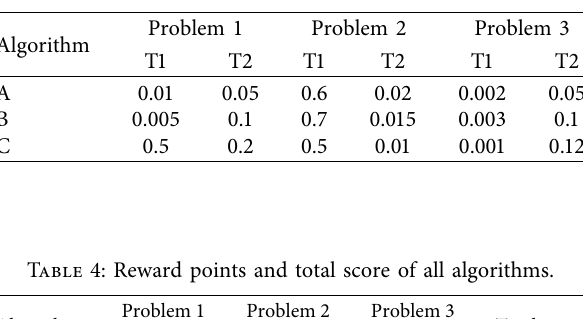
Table 3: Median fitness values obtained by all algorithms.